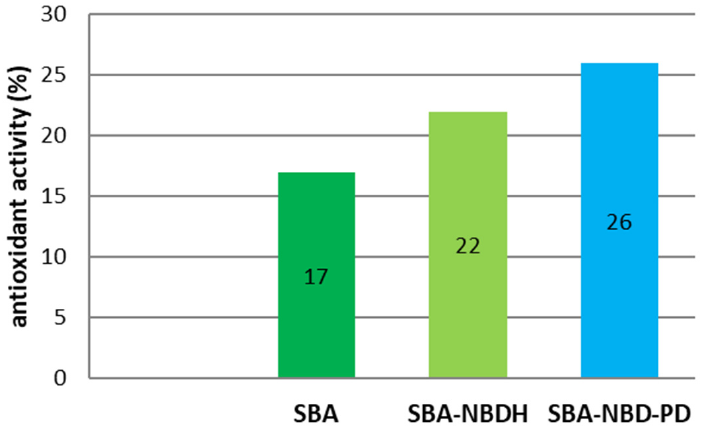
Figure 10. Antioxidant activity by DPPH assay of the SBA-15 with NBD derivatives.